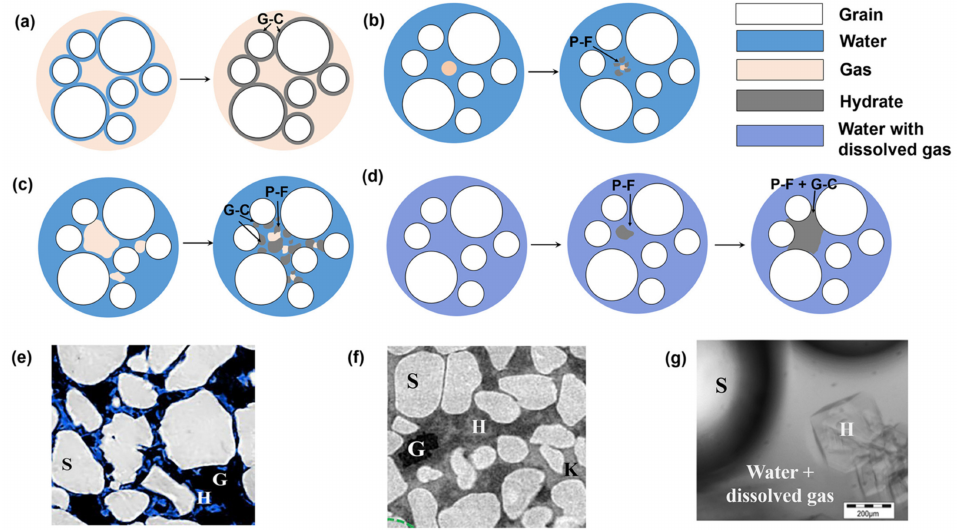
Figure 34. Diverse and complex morphology of hydrate in sediments. ( a – d ) Distribution charac- teristics of water, gas, and hydrate in systems with is abundant, scarce, moderate, and dissolved gas phase; ( e ) a micro-CT image of methane hydrate in the pore under excess-gas conditions; ( f ) a micro-CT image of methane hydrate in the pore under excess-water conditions; ( g ) a microscopic image of methane hydrate formed from dissolved methane in water. Reprinted with permission from Ref. [68]. Copyright 2022 American Geophysical